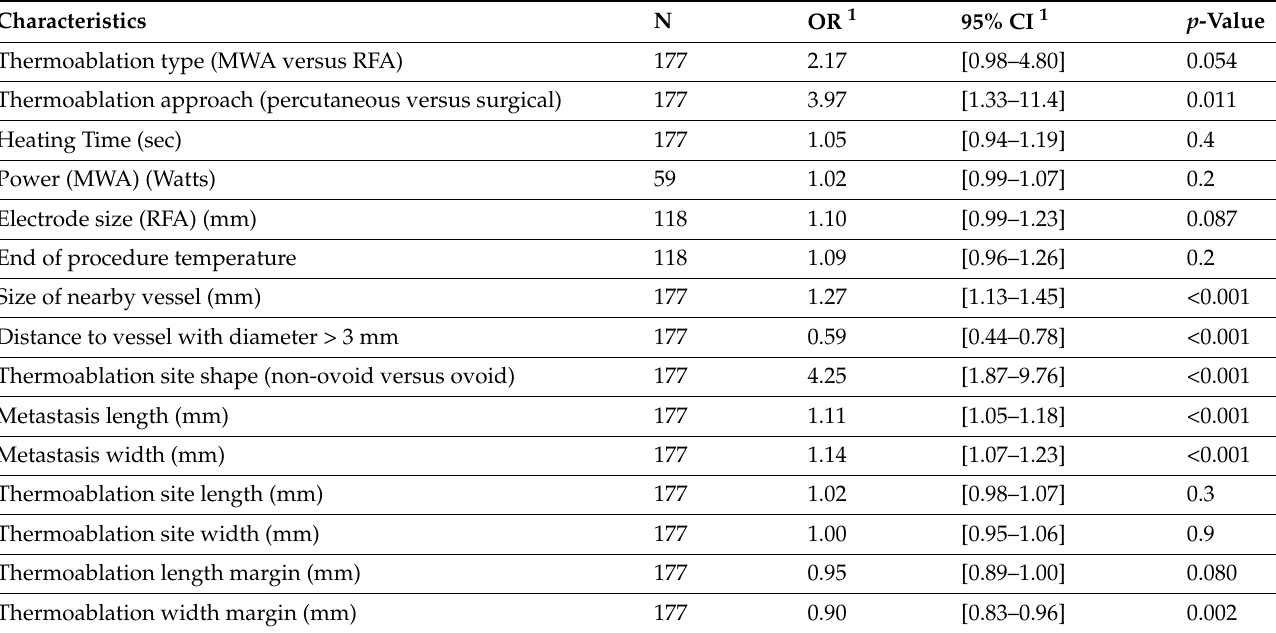
Table 5. Relation between metastasis characteristics and local